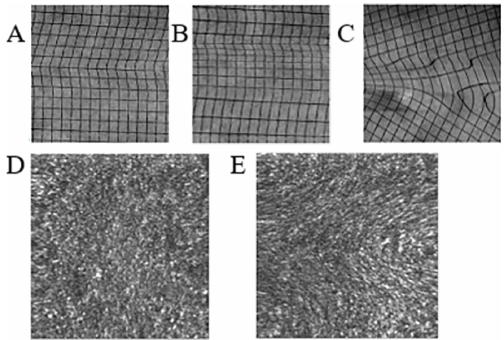
Figure 3. A-C) Distortions in scanned images, produced by (A) horizontal, (B) vertical, and (C) torsional motion within a single scan. (D-E) Successive frames from a 1° square region of foveal human retina. Panel D is typical, but a rapid horizontal eye movement has distorted the image in panel E. From Stevenson and Roorda